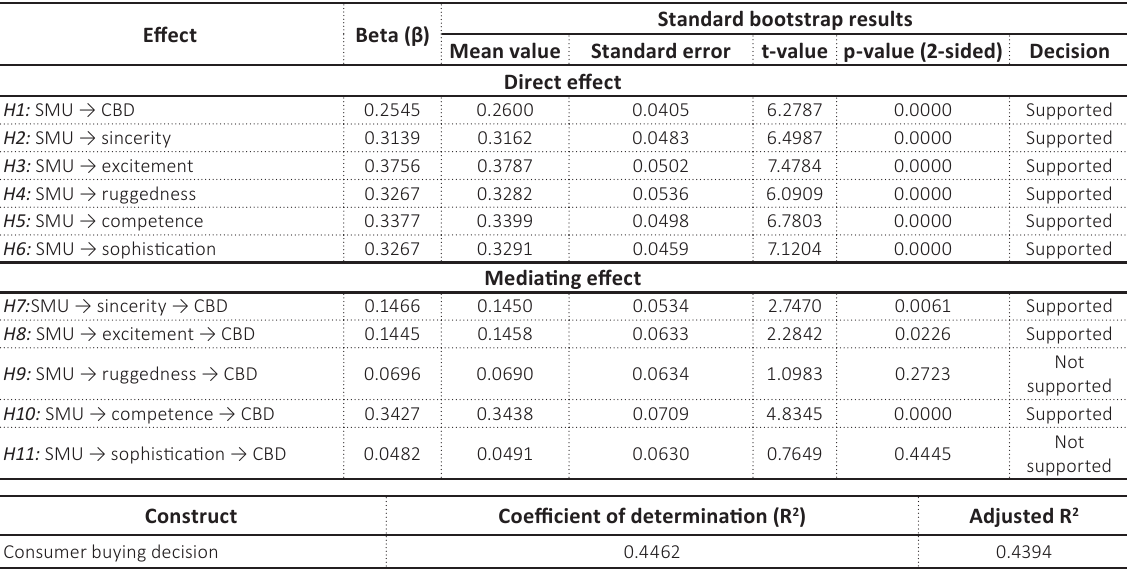
Table 5. Hypothesis